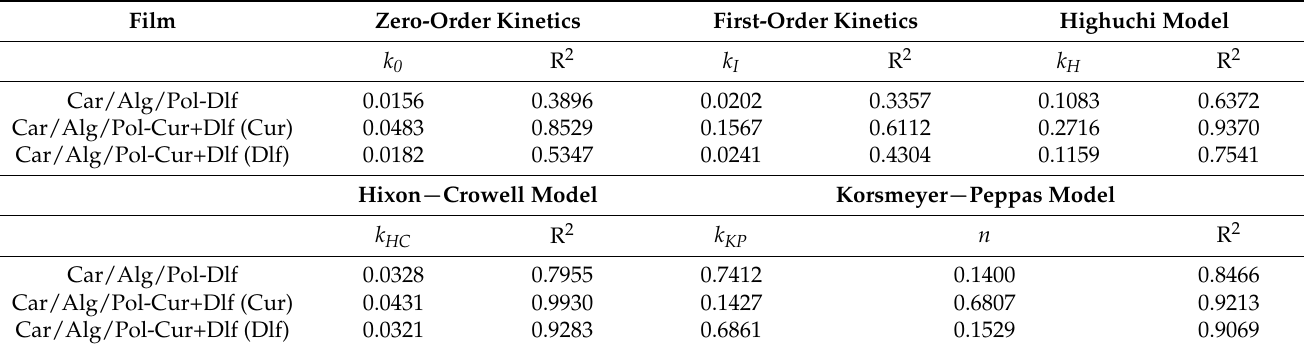
Table 3. Values of correlation coefficients, release rate constants and release